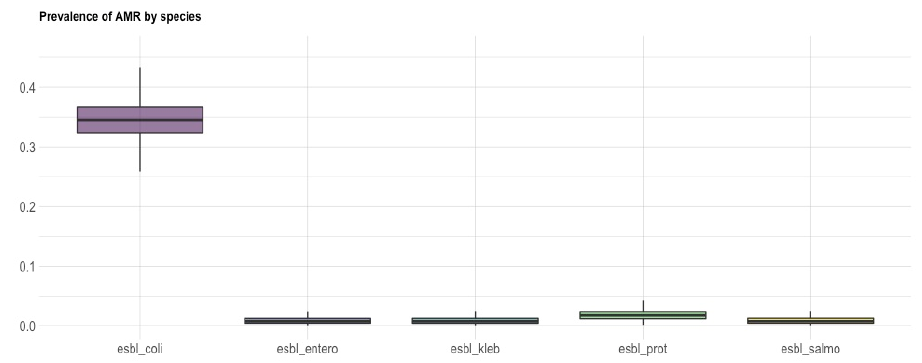
Figure 3. Box and whisker plot showing the prevalence of AMR ( y axis) of ESBL-producing E. coli , E. cloacae complex, K. pneumoniae , P. mirabilis and Salmonella spp. ( x -axis). The bold line shows the median value, while the length of the box represents the interquartile range.